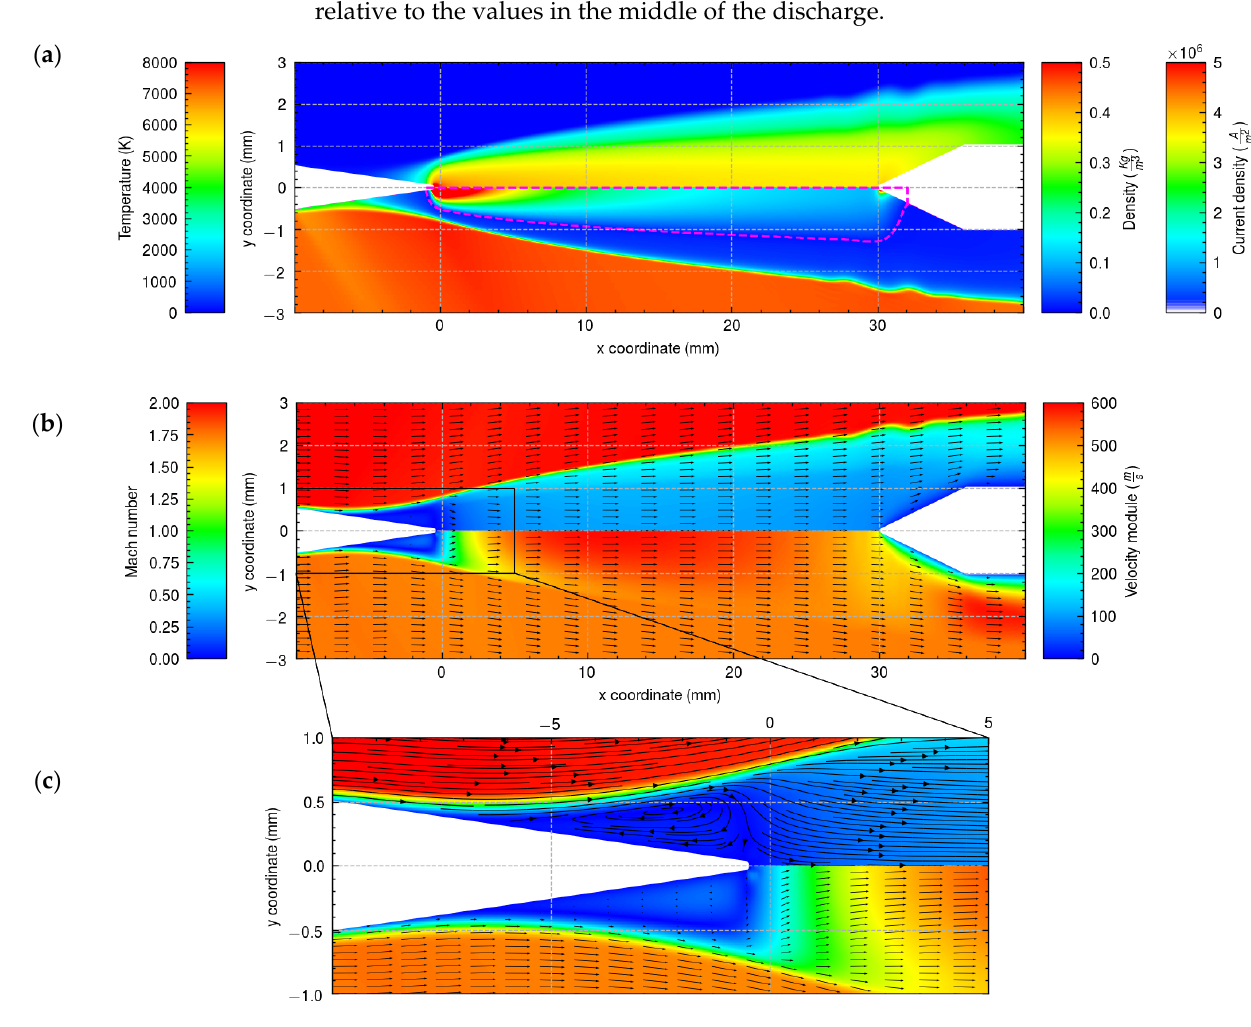
Figure 9. Calculation results in FlowVision for the 3 A current: ( a ) temperature distributions (top), as well as density (bottom) and current density (bottom, in dashed contour); ( b ) Mach number (top) and velocity modulus (bottom) distributions with velocity vector overlay, and ( c ) the near-electrode area is enlarged to show the separation zone. Please note the different scales for the longitudinal and radial axes.